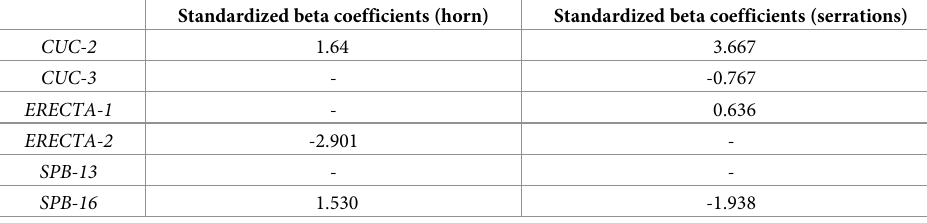
Table 3. Influence of each gene on